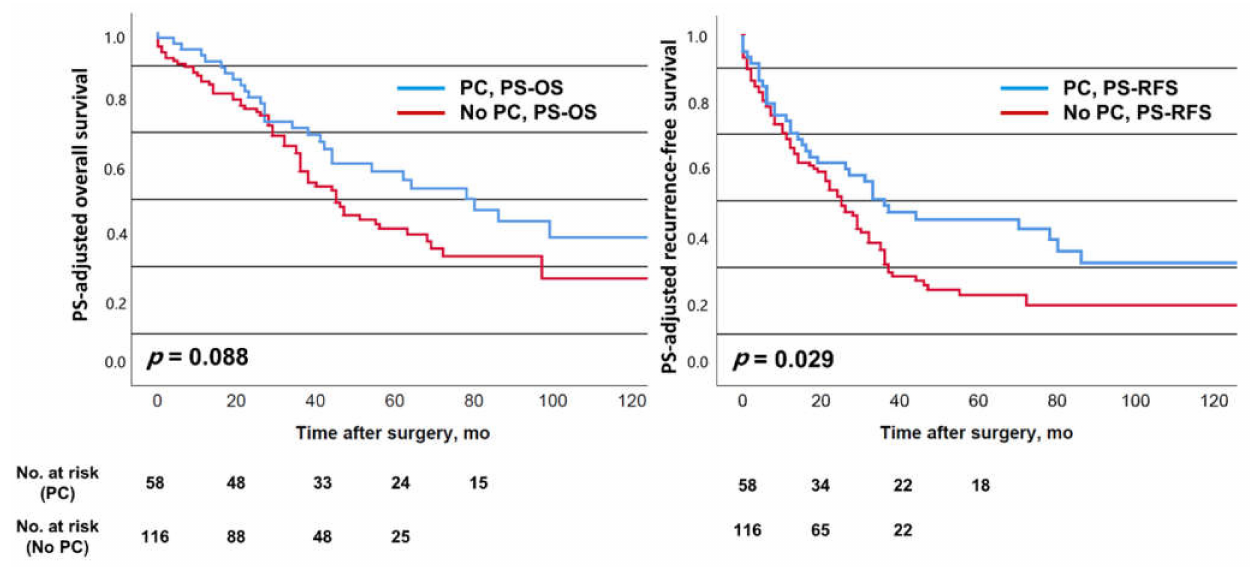
Figure 2. Propensity-score (PS) adjusted overall survival (PS-OS) and recurrence-free survival (PS-RFS) depending on the employment of pedicle clamping